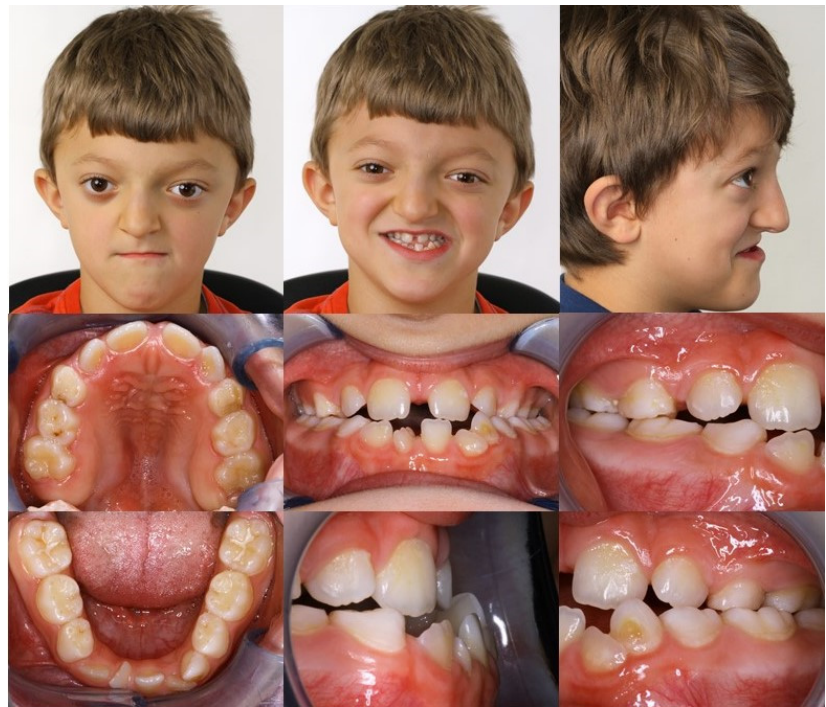
Figure 3. Intraoral and extraoral findings of the patient at initial examination. Extraoral: brachy- cephalus, exophthalmos, hypertelorism, and underdevelopment of the midface with absent zygo- matic prominence. Intraoral: high palatal vault, pronounced crowding in the upper and lower jaw, anterior and posterior crossbite, and Class III malocclusion.